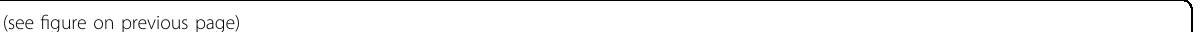
Fig. 1 EV-chromatin induces non-mutational dysfunction of p53 in BM stem cells through overexpression of the E3 ligase MDM2. a Particle number/mL measured by NTA. b TEM negative staining images of MV4-11 sEVs. Scale bar, 0.2 µm. c FACS analysis showing the expression of CD81 in MV4-11 sEVs. d Western blot analysis with various positive (CD81, HSP70, syntenin) and negative (calnexin and LC3B) markers of sEVs. e Expression of H2B and H3 histones in the isolated sEVs. f EV-DNA and genomic DNA measured by Quanti fl uor. g Work fl ow for sEV chromatin characterization. h AFM imaging of sheared chromatin highlighting the presence of DNA fi laments (white arrows) and protein dots (orange arrows) in both cells and sEV preparations. Chromatin and EV-chromatin showed fragments with sizes ranging from 100 bp to 500 bp after shearing by sonication. i Mass spec analysis of the pulled-down chromatin, showing histones (H2B and H4) and S100 as the most abundant proteins of EV-Chromatin. j S100A8/A9 levels in sEVs isolated from healthy donors and AML patients. k 3D confocal images indicating the co-localized and non-co-localized green (H2B-GFP) and red (EV-DNA) signals in different cell compartments. l Characterization of polymersome uptake by BM-MSCs. The fl uorescence signals of the green channel (EV-DNA, 488 nm laser) and the red channel (polymersomes, 532 nm laser) were detected inside the BM-MSCs. Scale bars, 10 µm. m Western blotting analysis revealing a decrease in p53 level upon treatment with MV4-11 sEVs. n MV4-11 sEVs but not fi broblast sEVs downregulate p21 expression in BM-MSCs, which was accompanied by an increase in MDM2 level. o p53 degradation upon leukemic EV-chromatin treatment. p Relative expression levels of p53 target genes (normalized to the internal control), highlighting the downregulating effect of the leukemic EV- chromatin packaged in polymersomes on p21 compared to fi broblast-derived EV-chromatin. q BM-MSC colonies were counted after 7 days of treatment with either sEVs, EV-DNA, or EV-chromatin. r Mean YFP fl uorescent intensity showing an increase in YFP-tagged MDM2 expression after treatment of BM-MSCs by EV-chromatin and EV-DNA. MFI results were normalized to the untreated cells. s MDM2 mRNA decay in BM-MSCs after Actinomycin D treatment demonstrating comparable mRNA levels in the presence of either EV-chromatin, EV-DNA, or empty polymersomes. t Relative expression level of p53 target genes after treatment with 5 µM of Siremadlin. Data were all expressed as means ± SD. P value was calculated by one-way or two-way ANOVA. * P < 0.1; ** P < 0.01; *** P < 0.001; **** P < 0.0001; ns, not signi fi